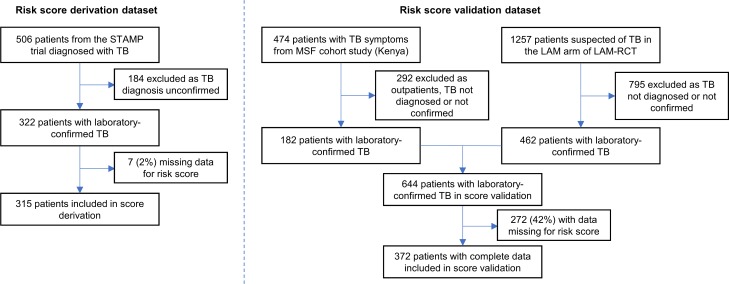
Study profile.LAM, lipoarabinomannan; MSF, Médecins Sans Frontières; TB, tuberculosis.